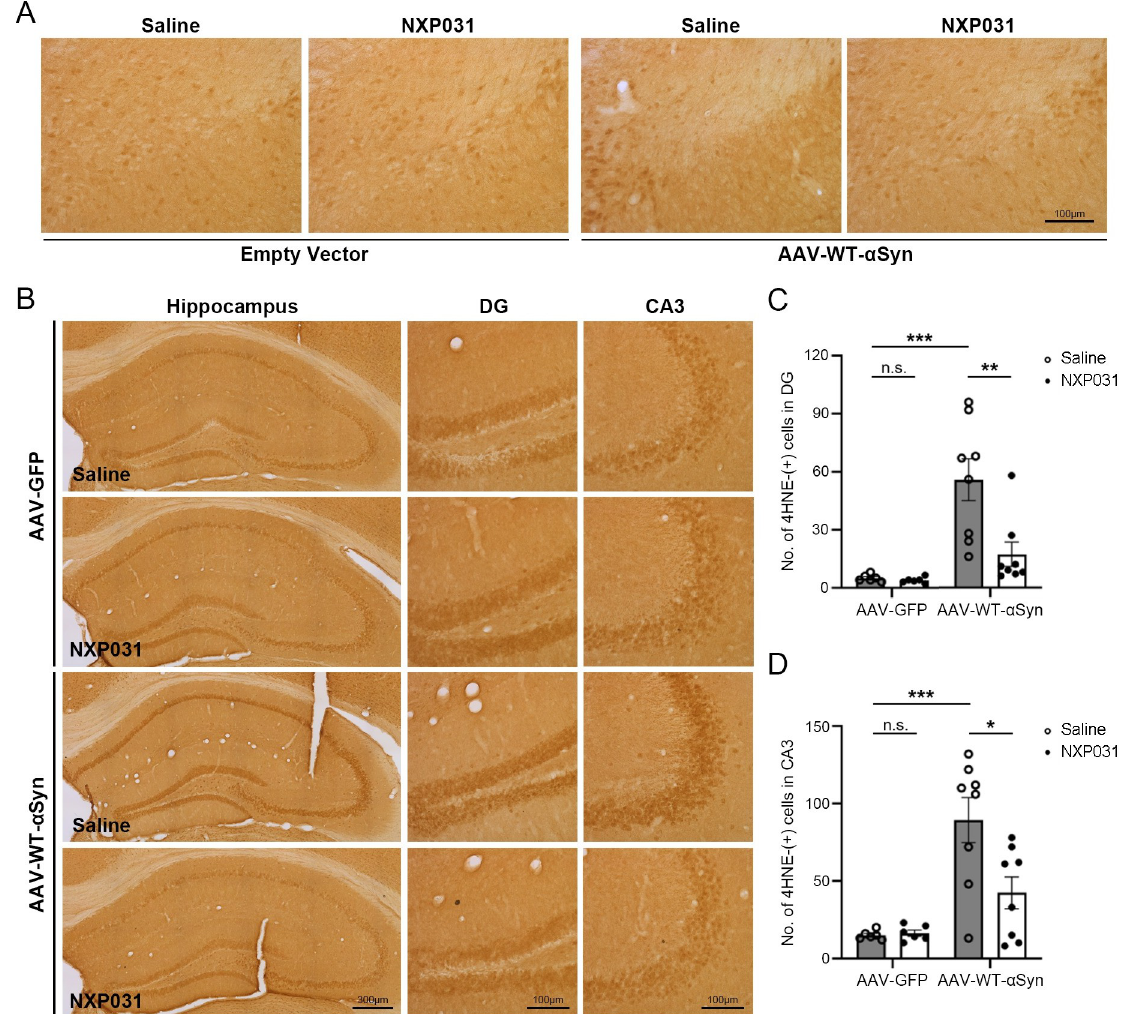
Fig 4. Effect of NXP031 on oxidative stress in the SN and hippocampus of mice after delivery of GFP-only or α -Syn AAV. (A) Representative micrographs of 4-HNE immunostaining in the SN. (B) Representative micrographs of 4-HNE immunostaining in the hippocampus. (C) The number of 4-HNE positive cells in the hippocampal DG. (D) The number of 4-HNE positive cells in the hippocampal CA3. Data are presented as the mean ± S.E.M. (Two-way ANOVA followed by Tukey’s test, � p < 0.05, �� p < 0.01, ��� p < 0.001 compared to selected group, n = 6–8 mice per